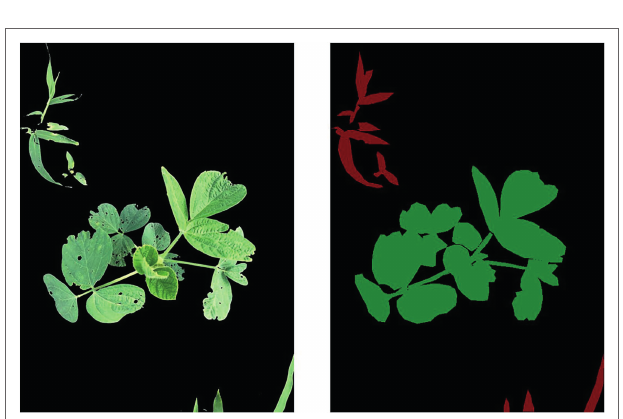
FIGURE 1 | Hyper green feature algorithm (A) RGB original image, (B) Binary image, and (C) Final image.